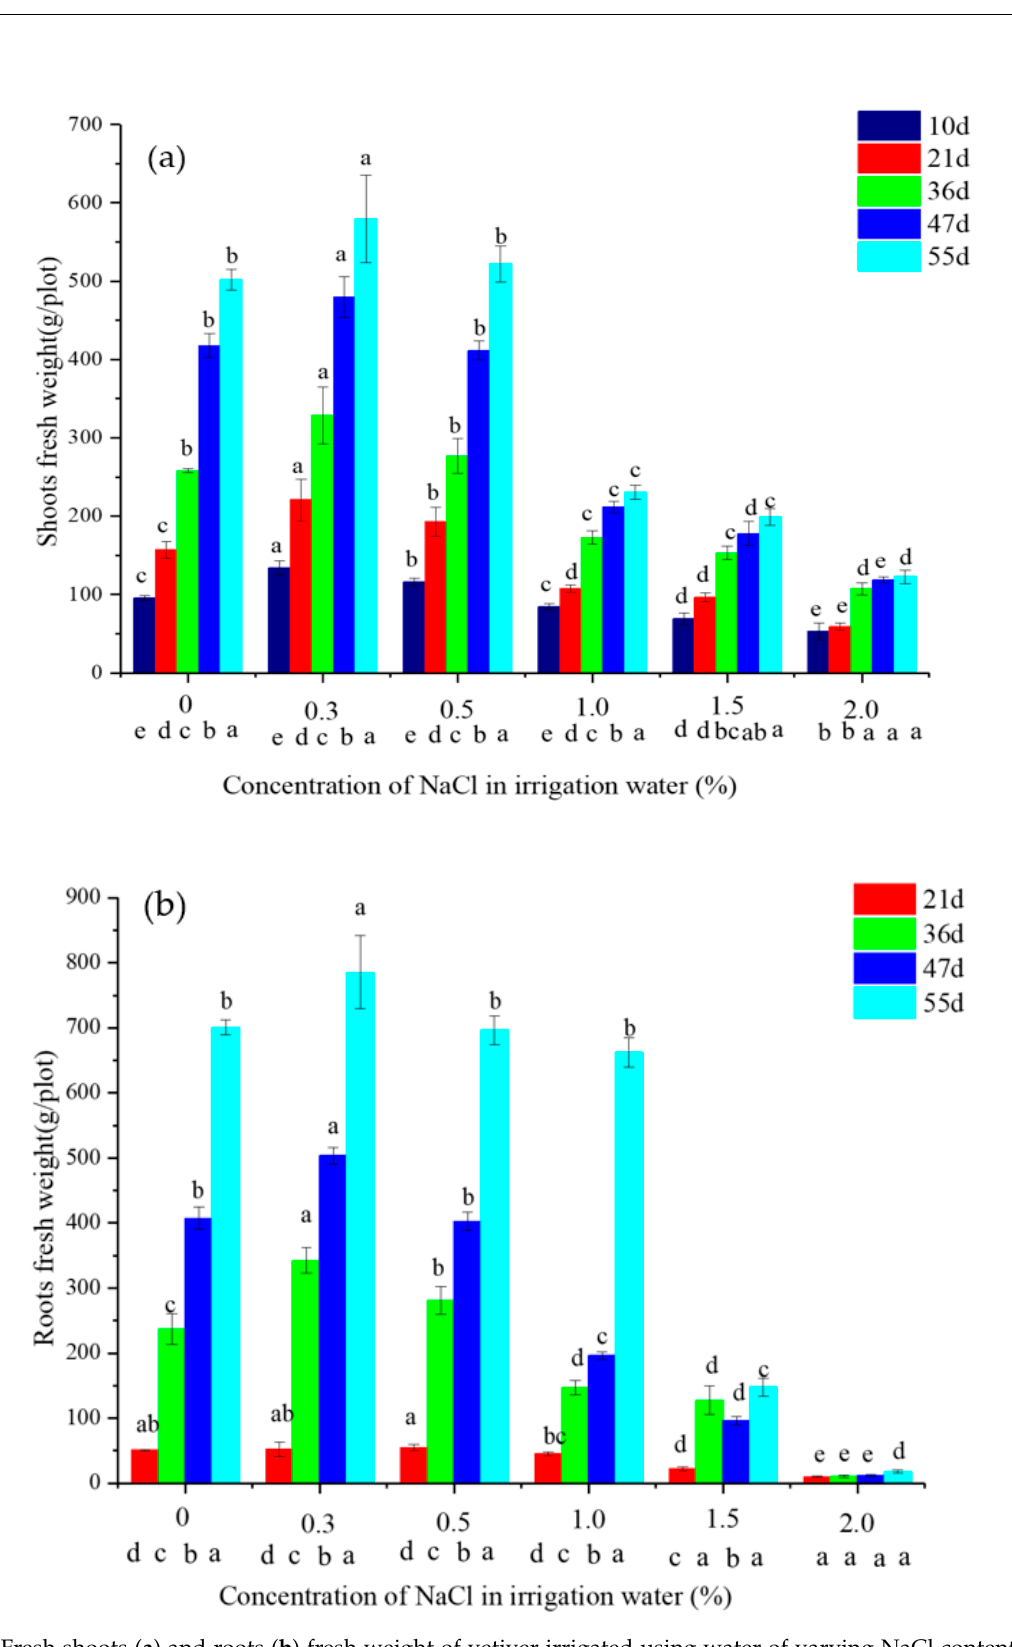
Figure 1. Fresh shoots ( a ) and roots ( b ) fresh weight of vetiver irrigated using water of varying NaCl content. Letters above the bars represent the significance of different salinities at the same time of growth ( p < 0.05). Letters below the x -axis represent the significance of different growth times at the same salinity ( p < 0.05). The data are shown as the mean ± standard deviation. The fresh weight of shoots and roots irrigated with 0.3% saline water increased by 14.8–40.6% and 3.1–44.3%, respectively, compared with that of no saline water (CK). Fresh